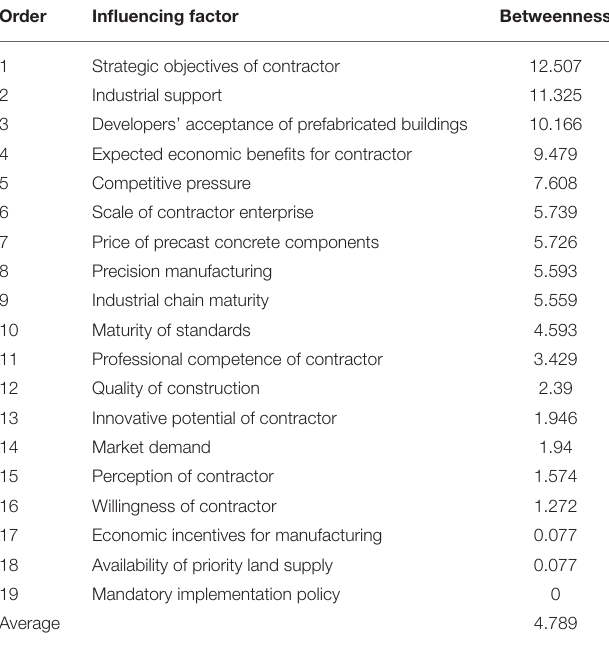
TABLE 3 | Analysis results of betweenness centrality for influencing